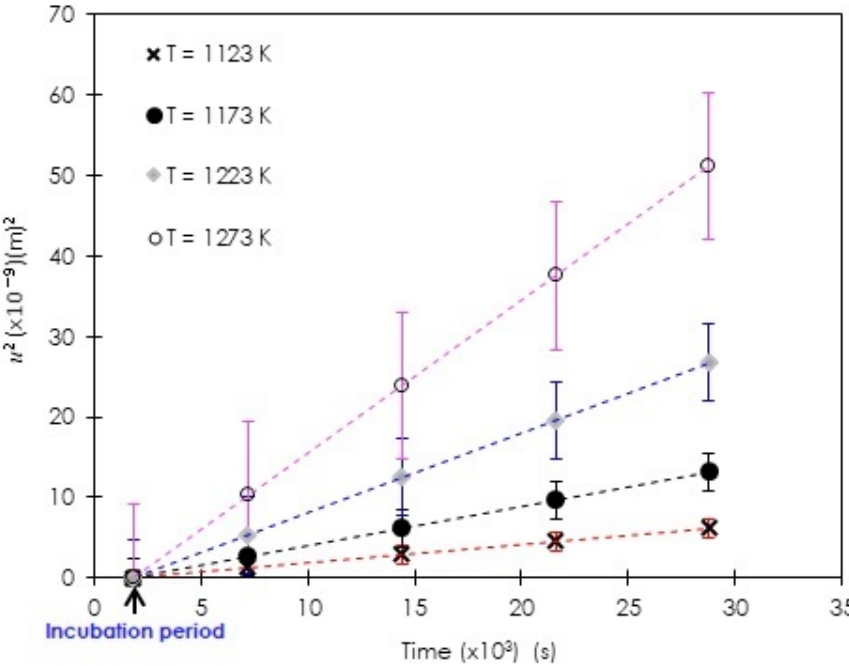
Figure 14. The plot of the square of Fe 2 B layer thickness versus exposure time.